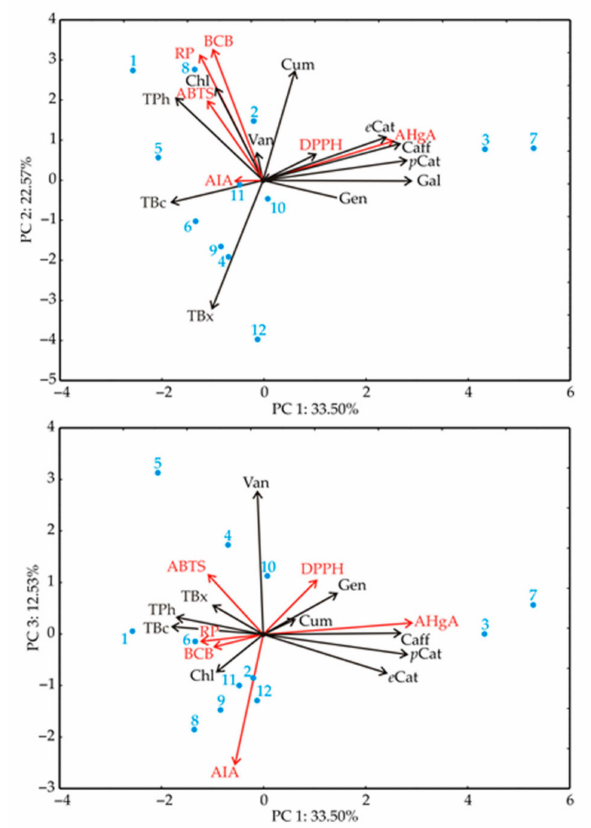
Figure 3. PCA ordination of variables based on correlations of phytochemicals, antioxidant and pharmacological